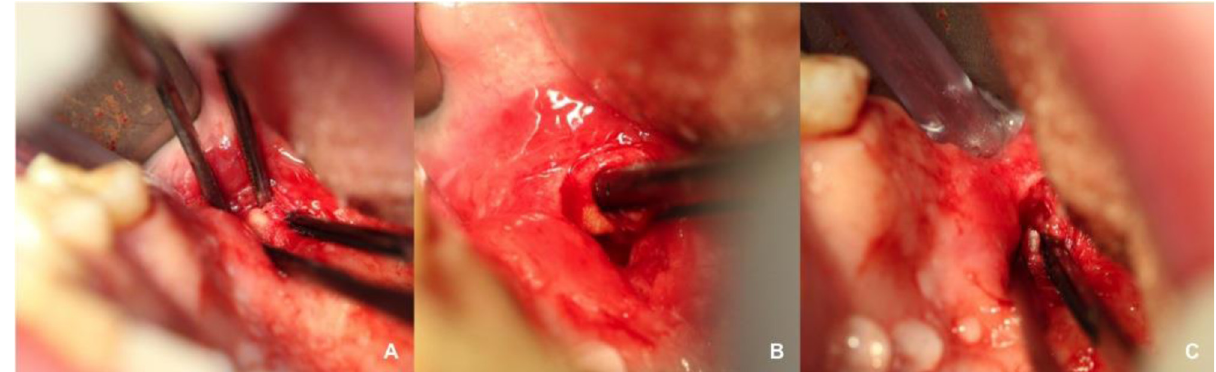
Fig. 3. Hamulotomy in the treatment of a case of PHS refractory to medical treatment (case not presented). (A) Careful dissection of the right hamular region. (B) Removal of the tendon bursa of the tensor veli palatini muscle (being careful not to damage the muscle or twigs of the little palatine nerve). (C) Bone resection of the residual hamulus (until the whole palpable prominence disappears). It is worth noting the secretion of the ipsilateral accessory salivary glands (due to the stimulation of the nearby parasympathetic secretory nerve fi bres during the